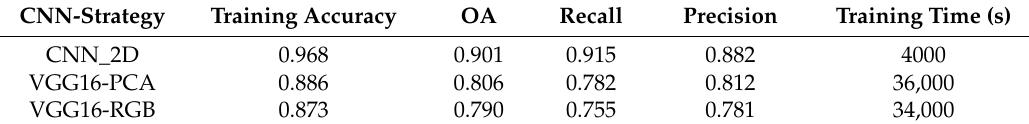
Table 10. The accuracy and loss of CNN_2D, VGG16-PCA, and VGG16-RGB.